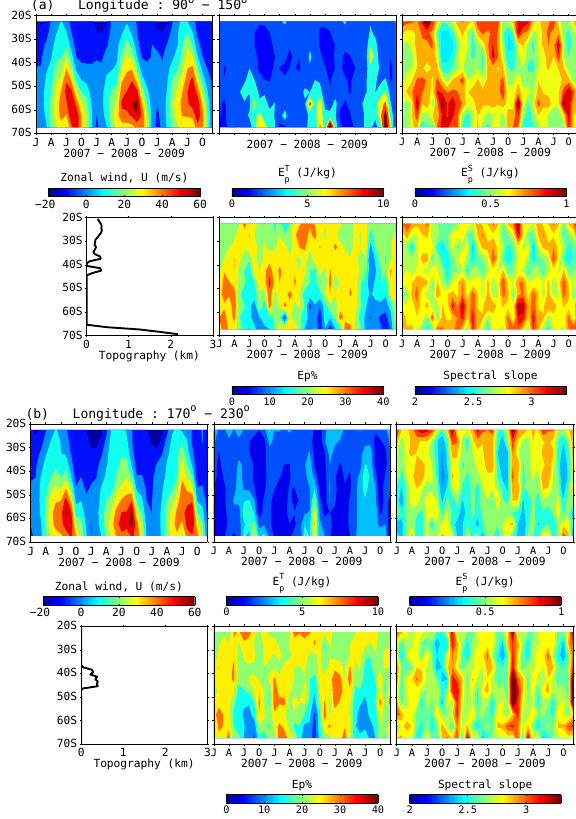
Figure 8. Same as Fig. 6 except in the SH at 20–70 ◦ S.